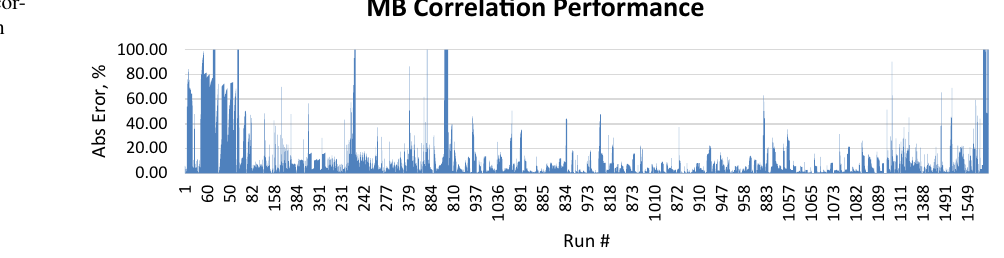
Fig. 2 Mukherjee and Brill cor- relation performance through the entire